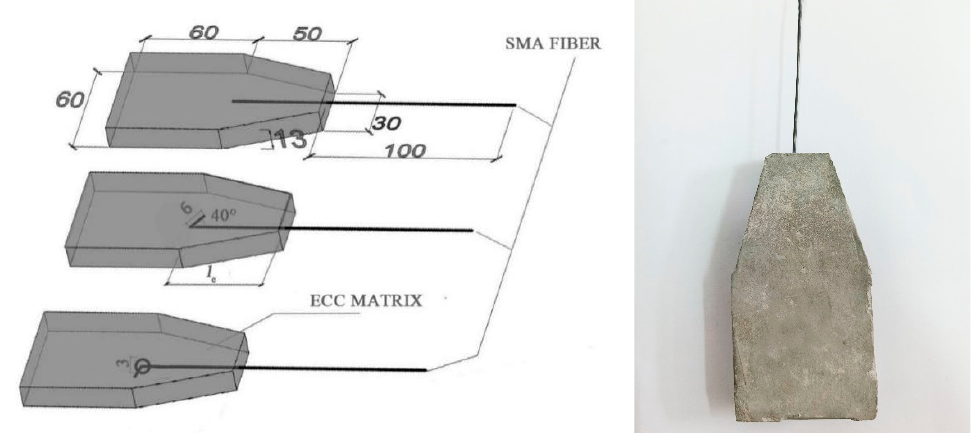
Figure 7. Specific size of specimen. le is the bonding length, from top to bottom are straight specimens, hook specimens, and knotted specimens. Table 3. Test specimen grouping table.